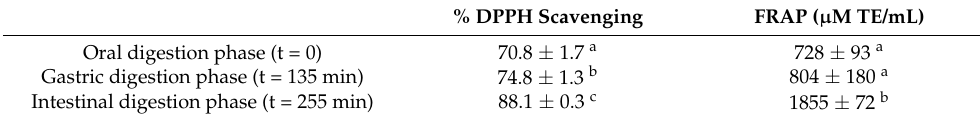
Table 3. The oxidative stability (% DPPH inhibition, FRAP) of the sports